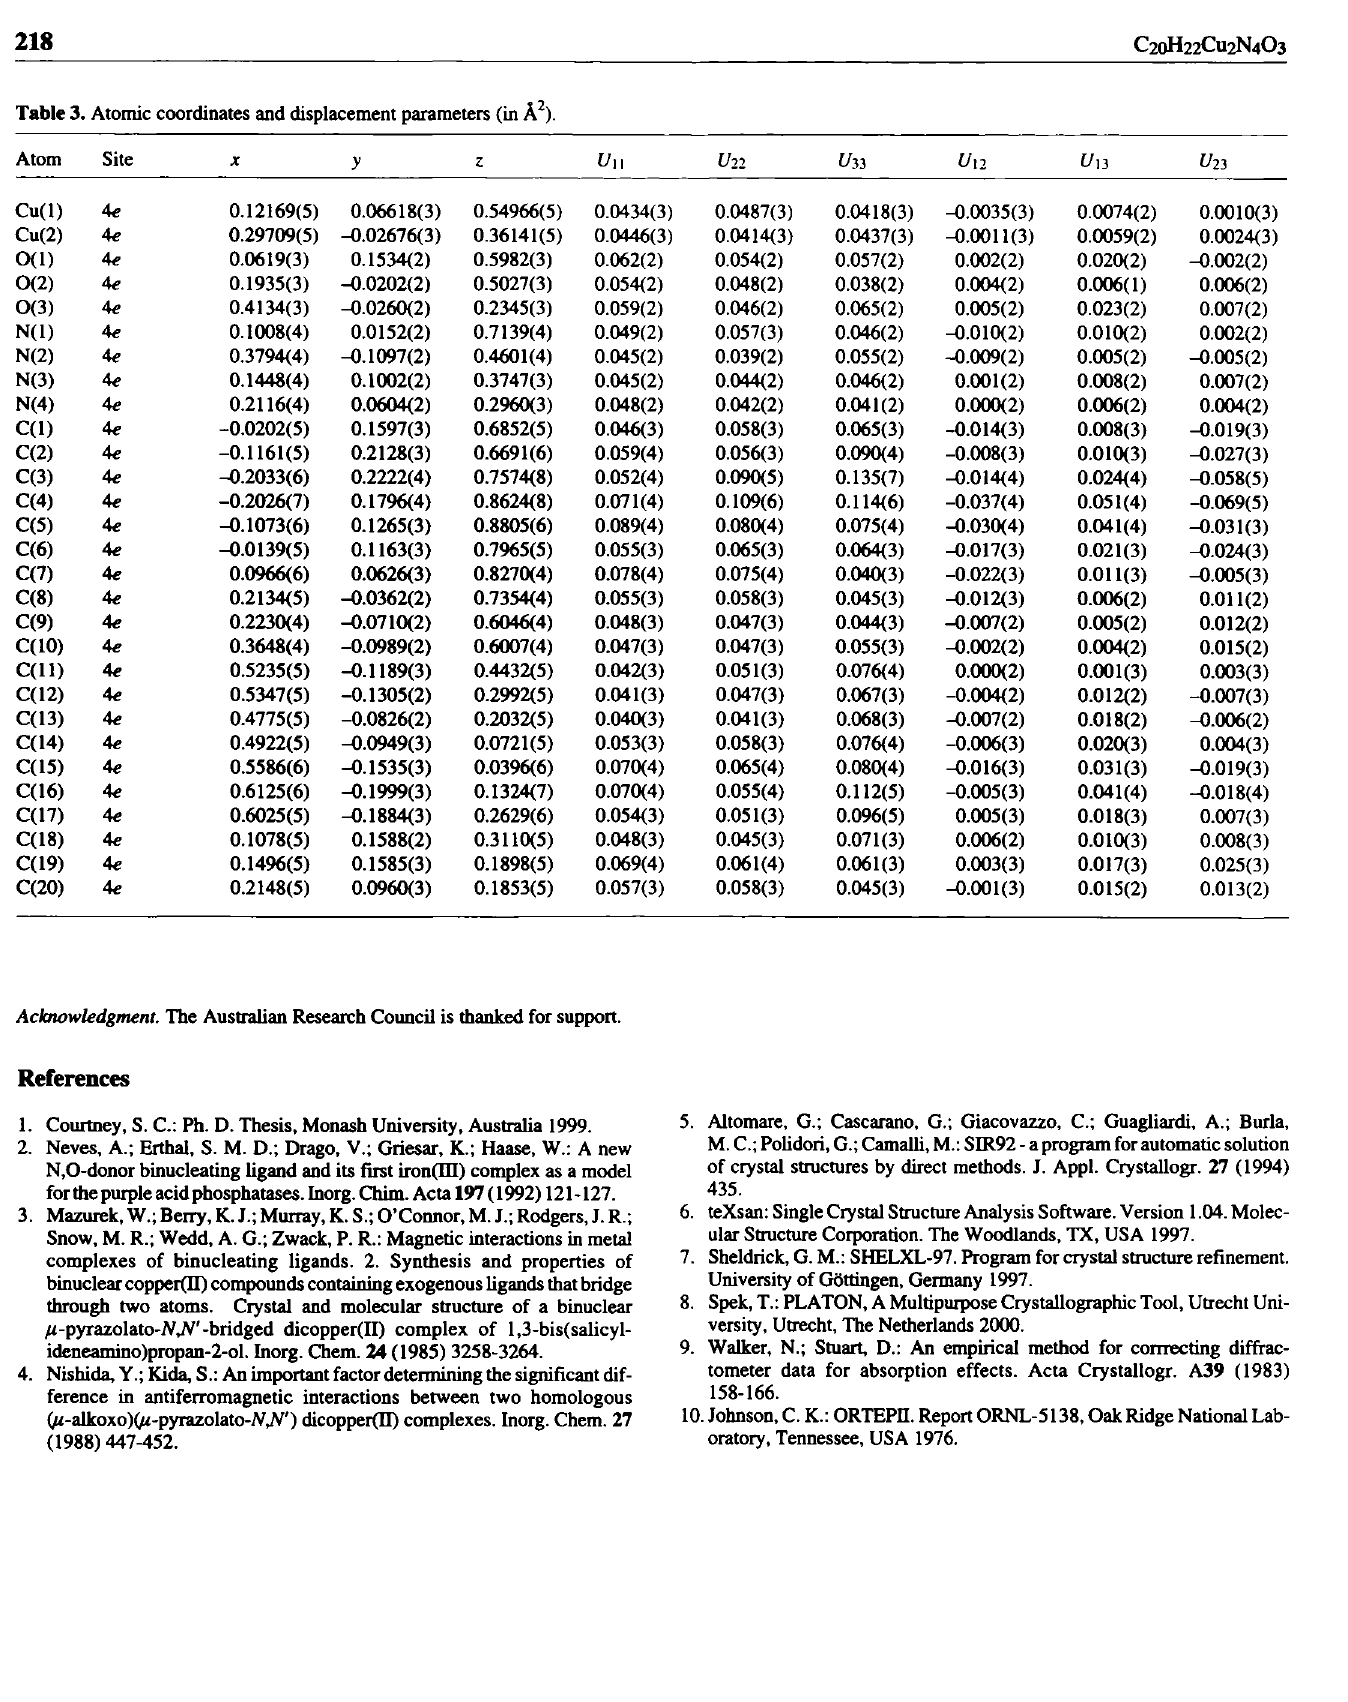
Table 3. Atomic coordinates and displacement parameters (in Â 2